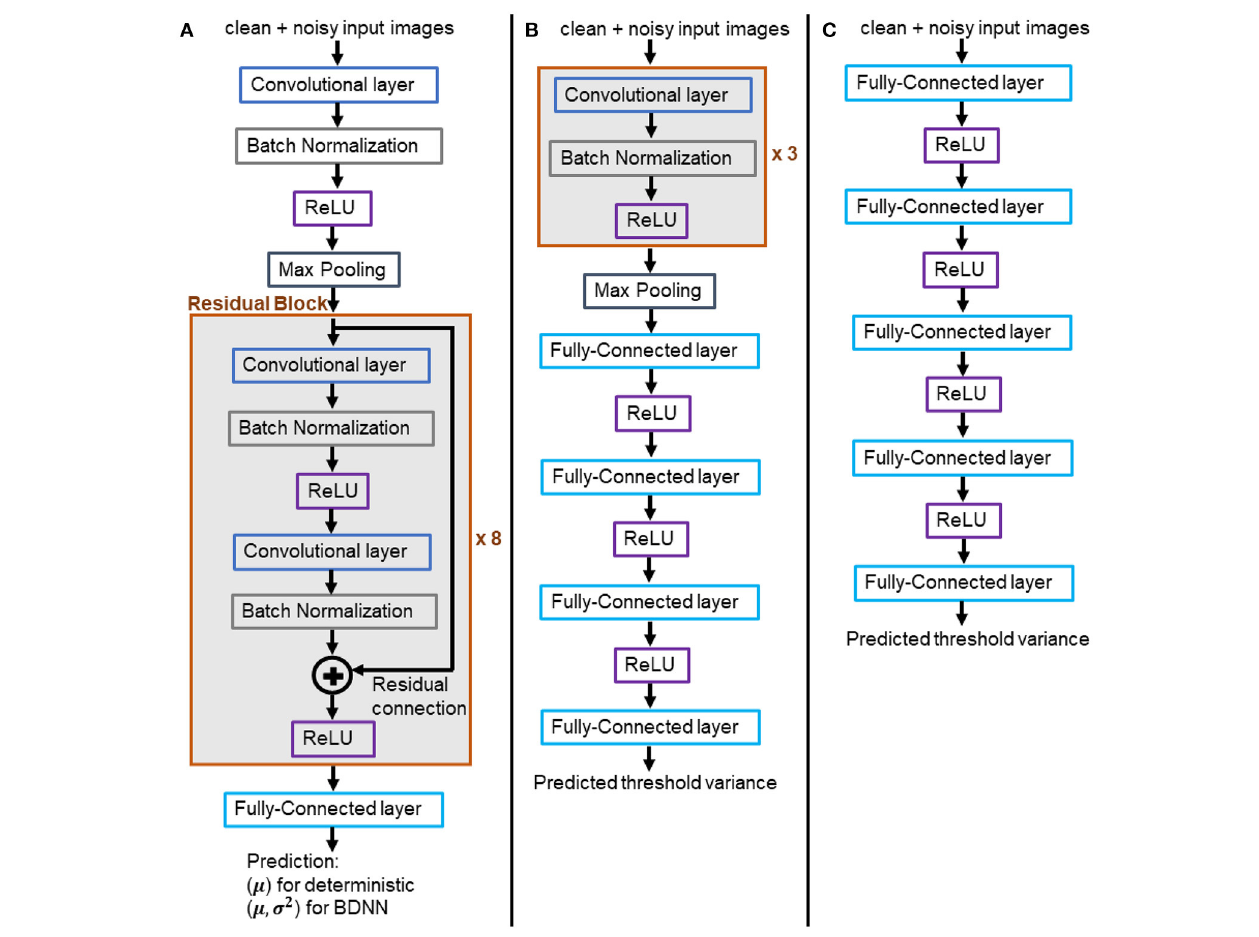
FIGURE 3 | (A) Architecture of the trained BDNN models for uncertainty quantification. Deterministic models share the same architecture. (B,C) Models for learning the threshold variance. (B) Learned threshold model for PathMNIST dataset. (C) Learned threshold model for DermaMNIST and OrganAMNIST datasets.